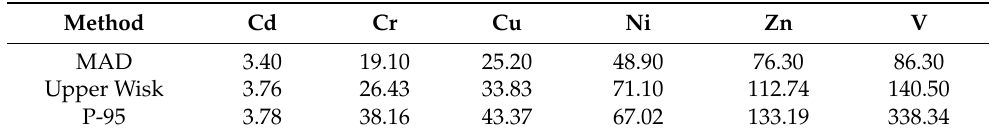
Table 7. Threshold values in mg × kg − 1